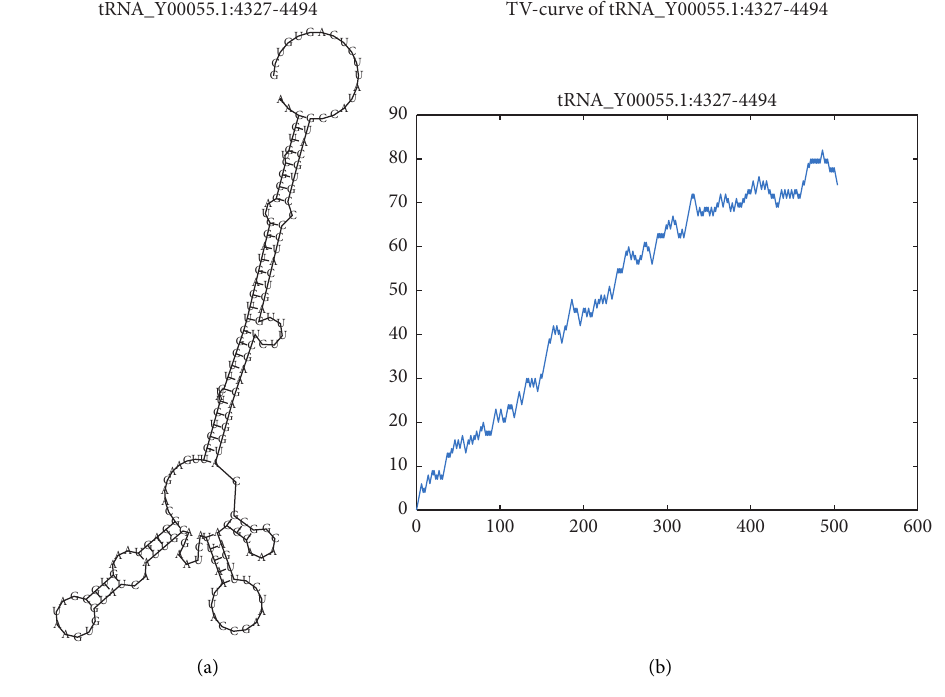
Figure 3: The TV-curve of tRNA_Y00055.1: